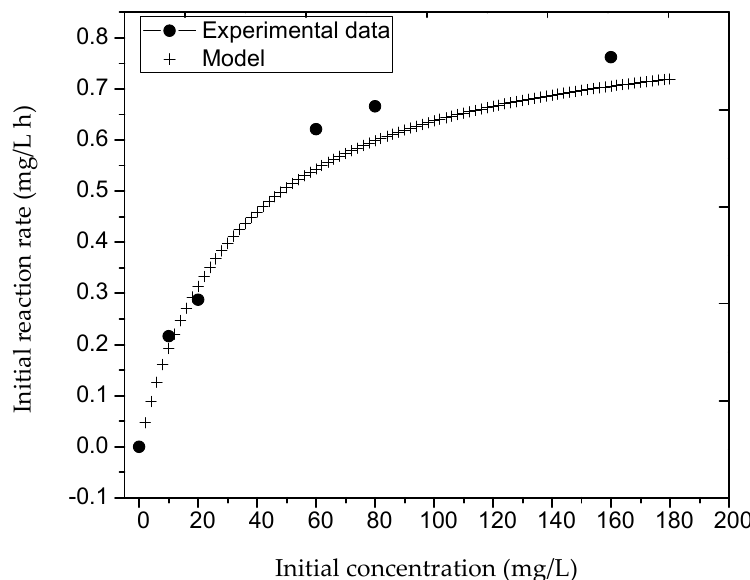
Figure 7. Heterogeneous LH catalysis model applied to the degradation of acetaminophen in an RFR reactor. The solid line represents the model and the points represent experimental data (catalyst mass = 1 gr/L, rotational speed = 54 rpm, radiation of λ = 254 nm, number of lamps = 6, reaction volume = 12 L, maximum reaction time = 50 h).